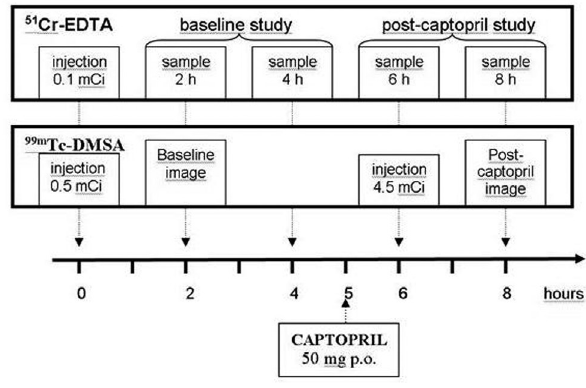
Figure 1 - General sequence of the protocol, including radiopharmaceutical administration and sample